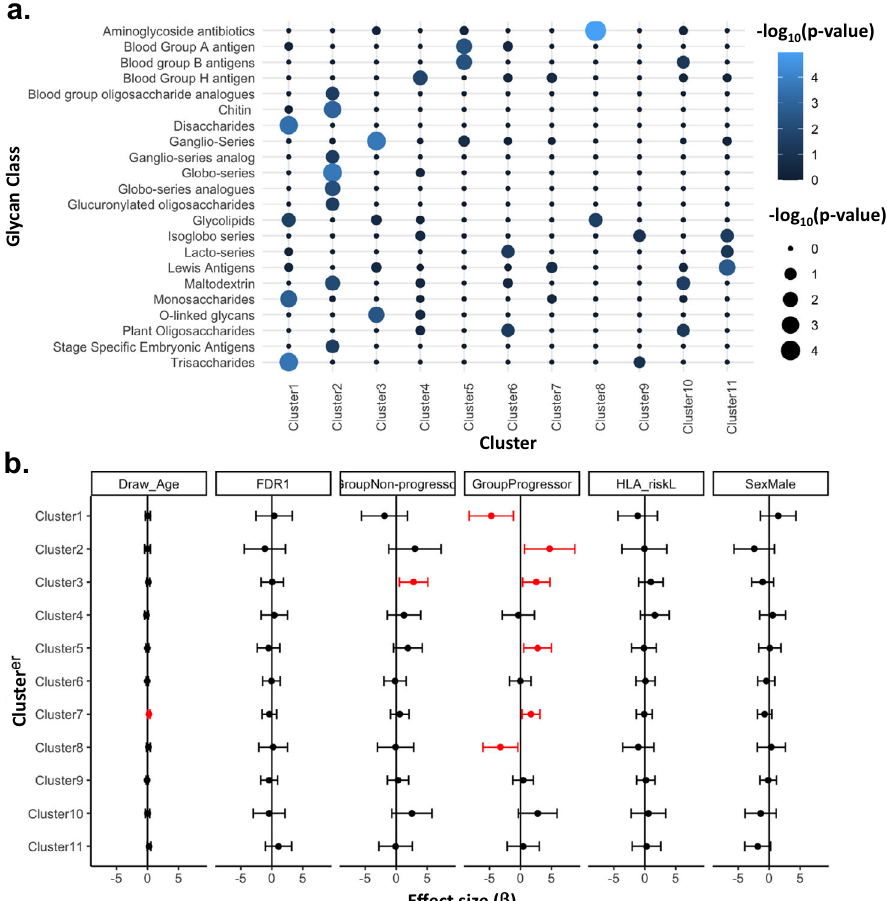
T1D, HLA risk, and sex in DAISY participants ( n =112). Effect size (dots) and 95% con fi denceinterval(bars) are presented.All p valuesweretwo sided and a p <0.05 wasconsideredsigni fi cant(signi fi cantassociationsaredisplayedasred,whilenon- signi fi cant associations are displayed as black). Source data are provided as a Source Data fi